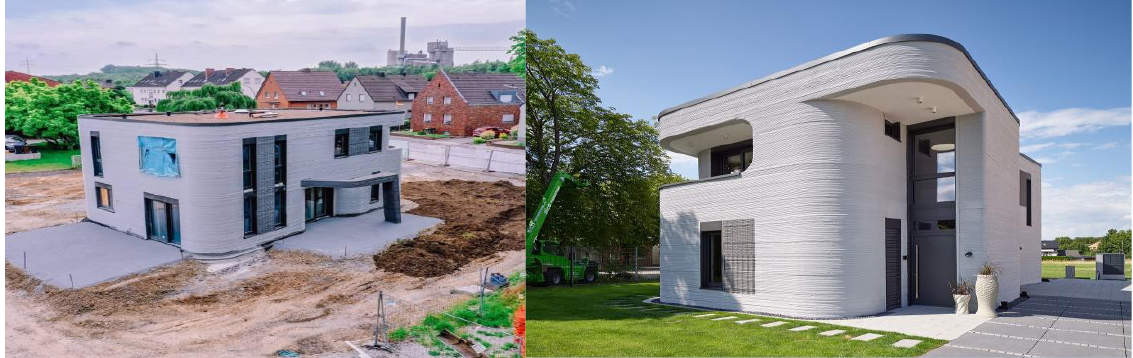
Figure 10: The Germany's First 3D-Printed Residential Building